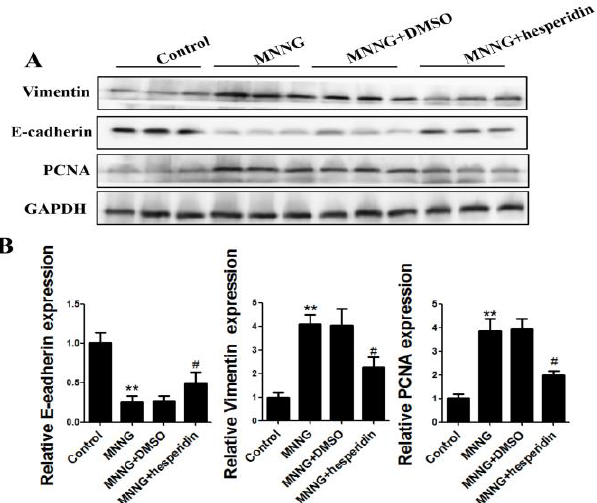
Figure 6. Hesperidin attenuated EMT and proliferation elicited by MNNG. Rats were divided into a control group, an MNNG group, an MNNG and solvent control group, and an MNNG and hesperidin group: ( A ) analysis of protein expression of EMT and proliferation markers by Western blotting. Tissues were from n = 3 rats as representative images; ( B ) real-time PCR analyzed mRNA levels of EMT and proliferation markers. Real-time PCR results are the samples from 3 rats, and the experiment was repeated three times. GAPDH served as the housekeeping gene; ** P < 0.01, compared with control group; # P <0.05; ## P <0.01; compared with MNNG group.